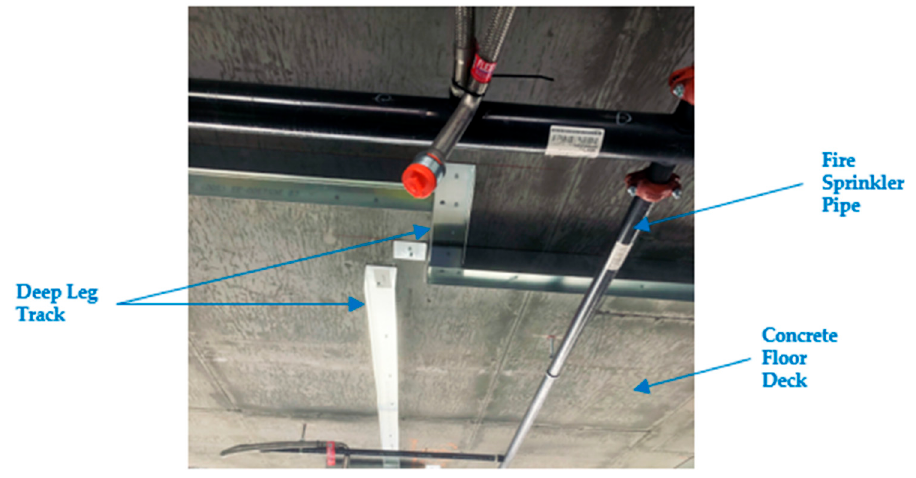
Figure 10. Example deep-leg track preinstallation.